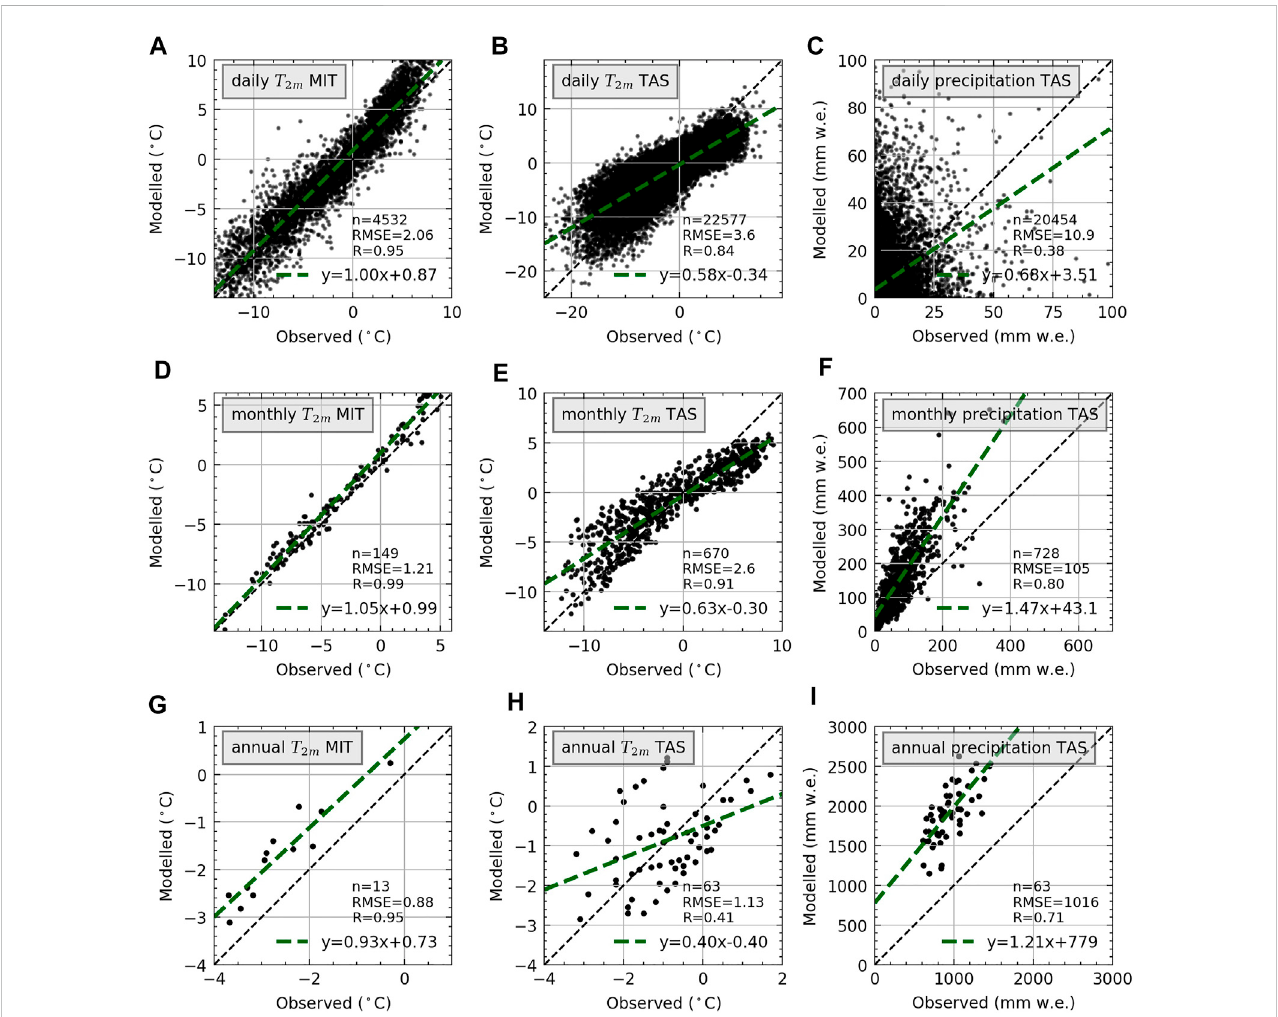
FIGURE 2 Evaluation of RACMO2 variables T 2m and precipitation at daily (A, B, C) , monthly (D, E, F) , and annual (G, H, I) time scales. 23 values are not shown in (C) due to the choice of x and y limits. Dashed line represents a 1:1 relationship between model and observations. A linear fi t is plotted with a dark green line and the equation is highlighted in the bottom right corner of each subplot. Number of observations (n), Root Mean Square Error (RMSE) and the Pearson correlation coef fi cient (R) are highlighted in the bottom right of each